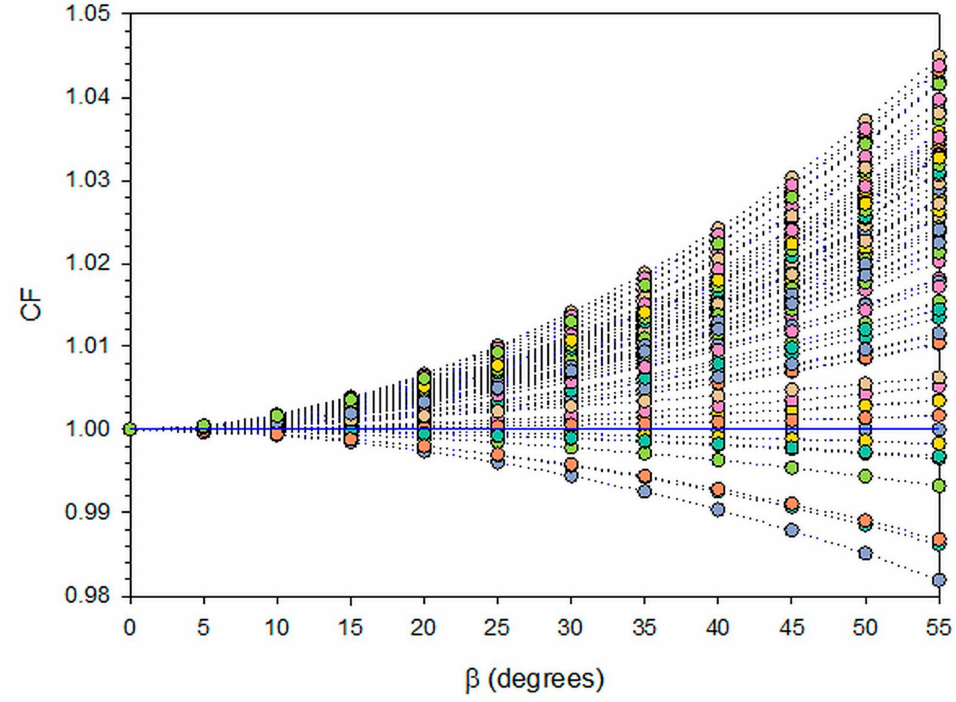
Figure 10. Variation of the correction factor, CF, as function of the tilt angle of the inclined flat plane, β , under all-sky conditions and averaged over the period 2005–2016. The dotted lines are the best-fit curves to the data points for each site, expressed as 3rd-order polynomials. The blue horizontal line indicates CF =